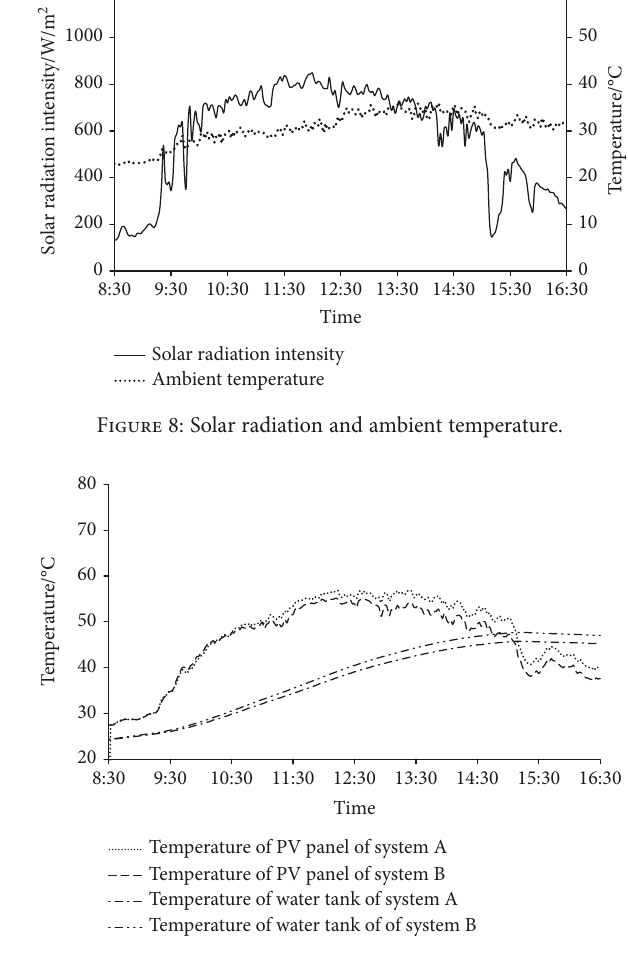
Figure 9: Temperature variation of PV panel and water of heat exchange